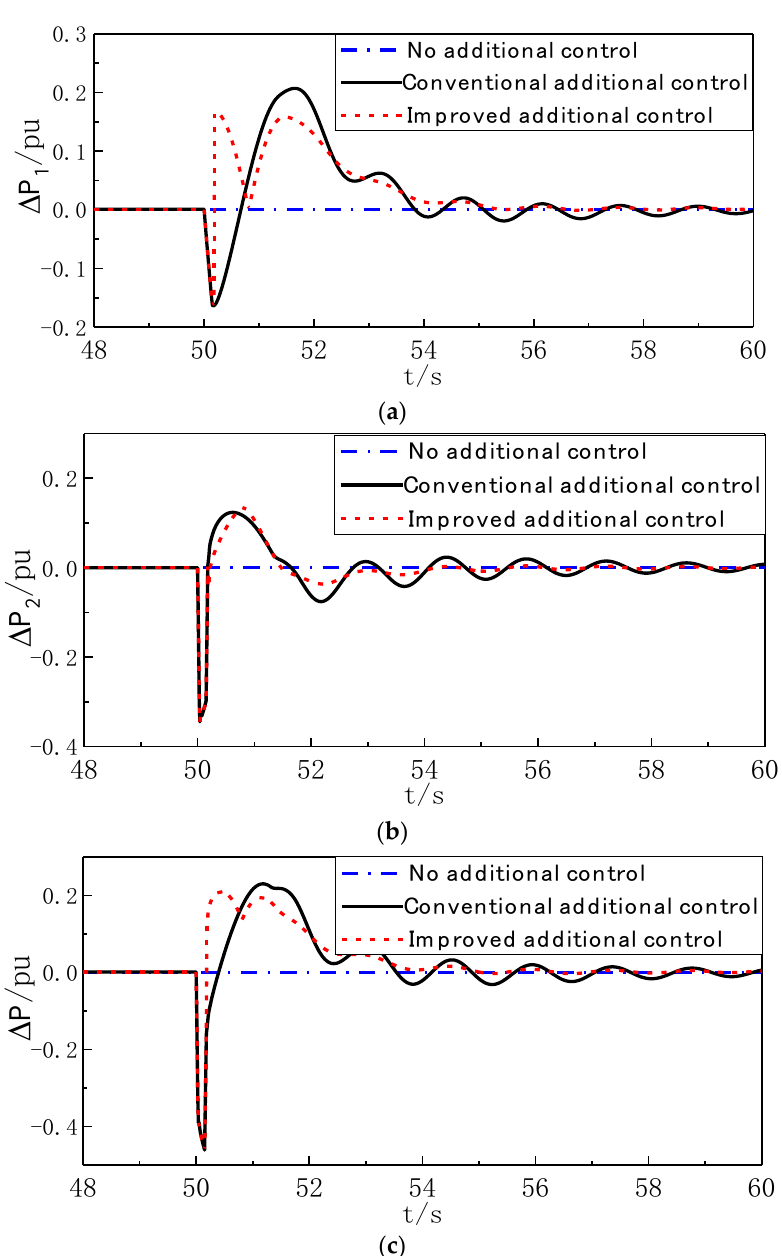
Figure 9. Change of additional power under a short-circuit fault by three different control methods ( a ) Additional active power produced by droop control of DFIGs, △ P 1 ; ( b ) Additional active power produced by inertial control of DFIGs, △ P 2 ; ( c ) Total additional power, △ P.